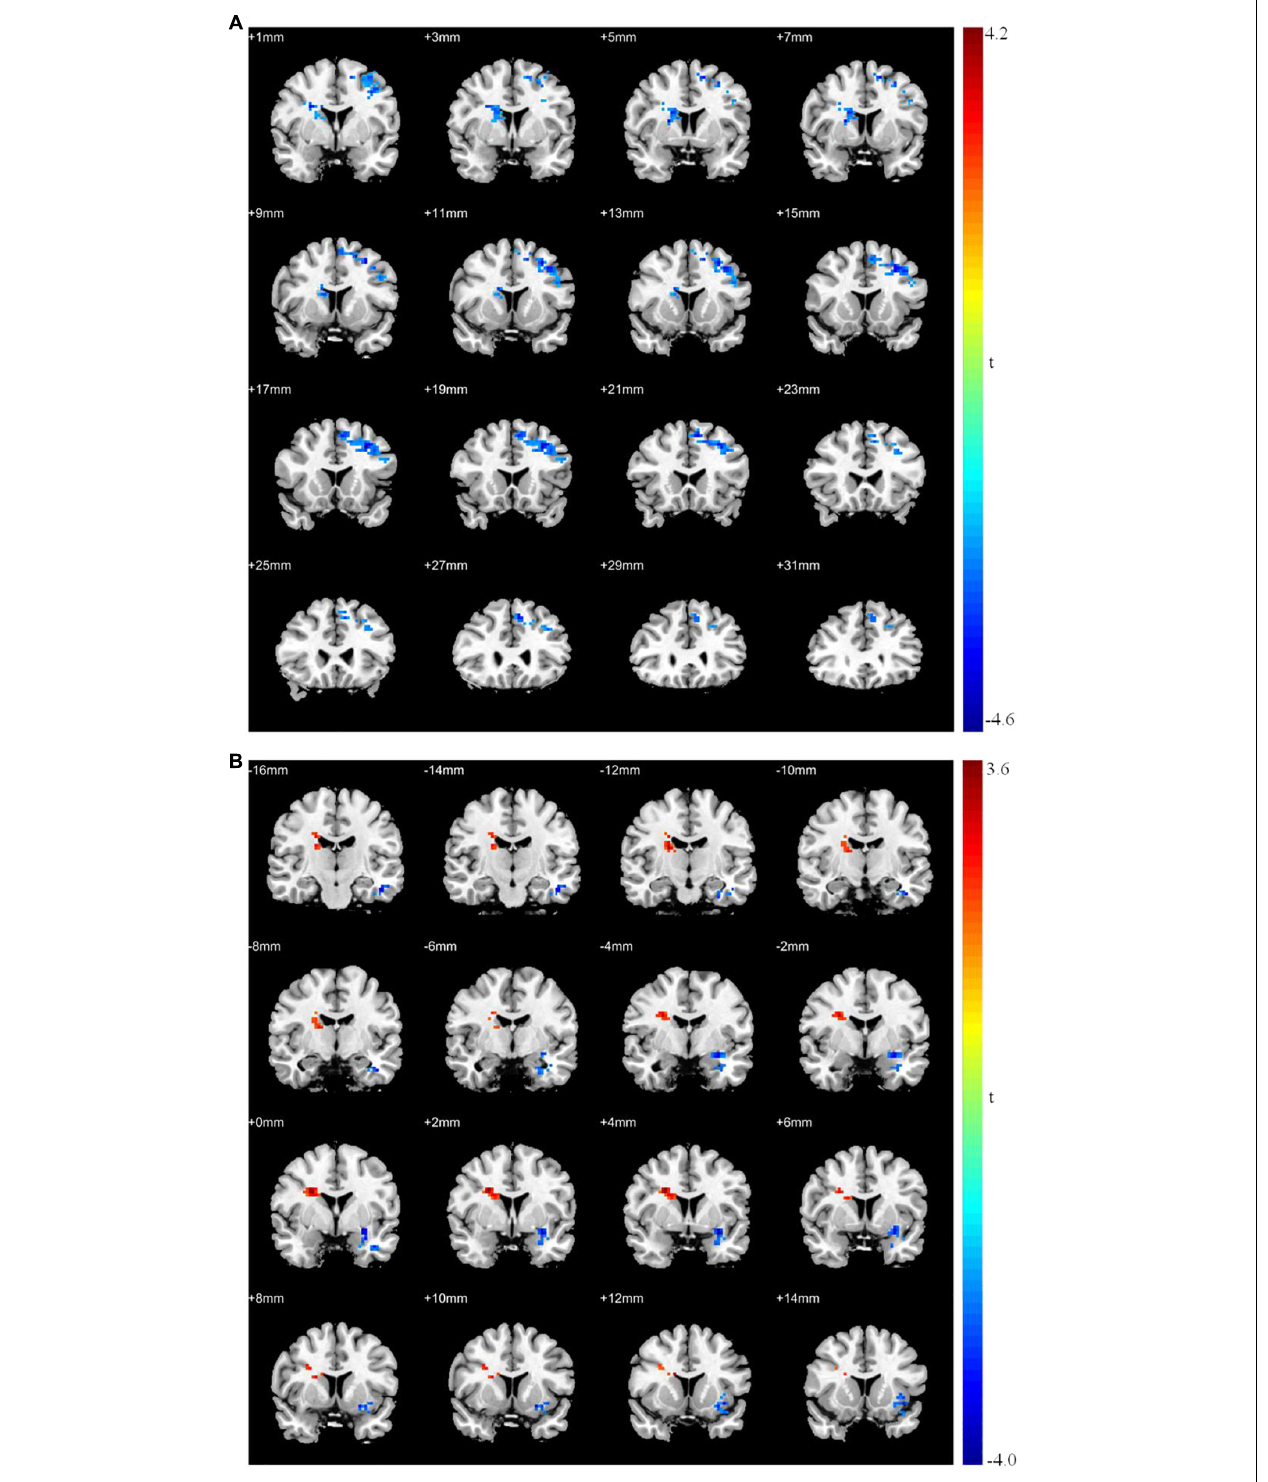
FIGURE 3 | Granger causality analysis between patients with MDD and healthy controls. (A) Significant different brain regions from seed point (LMFG) to whole brain regions; (B) significant different brain regions from whole brain regions to seed point (LMFG). Red areas show brain regions where patients with MDD had increased causal connectivity than healthy controls; Blue areas show brain regions where patients with MDD had decreased causal connectivity than healthy controls. The color bar represents t -values.